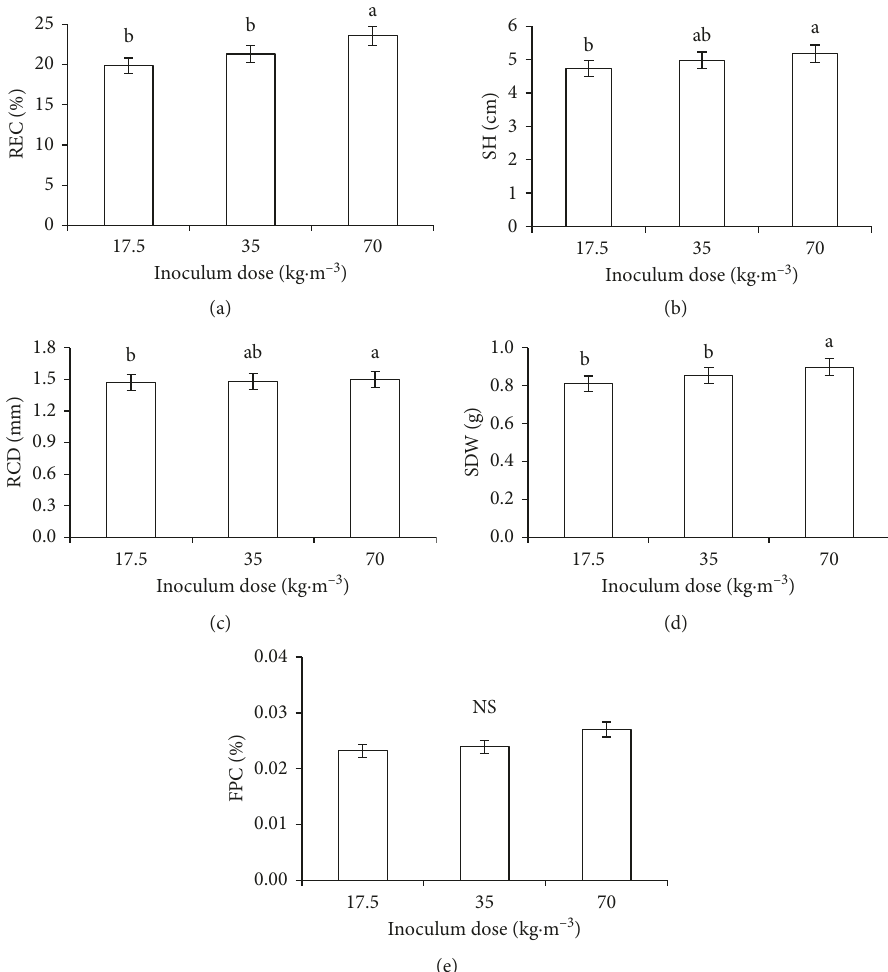
Figure 2: (a) Root ectomycorrhizal colonization (REC), (b) shoot height (SH), (c) root collar diameter (RCD), (d) shoot dry weight (SDW), and (e) foliar P content (FPC) of P. patula seedlings as a function of inoculum dose. Bars indicate standard error. Columns with different letters indicate significant difference ( P ≤ 0 . 05) according to the multiple range test of Duncan. NS � not